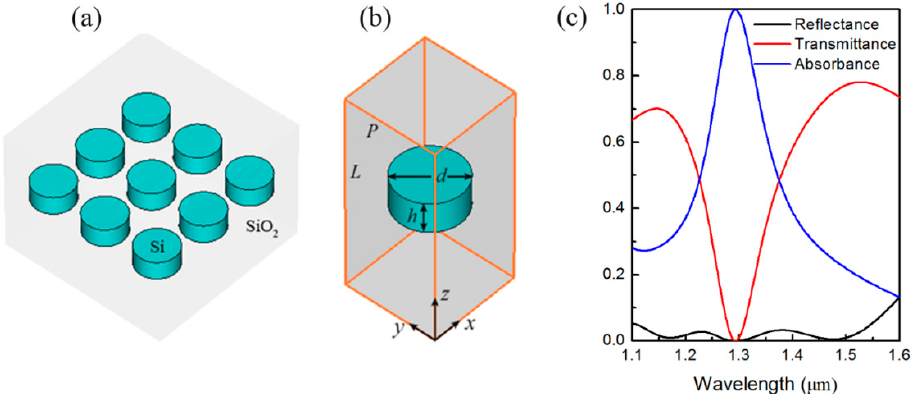
Figure 1. Schematic representation of narrowband all-dielectric metasurface composed of only a single layer of subwavelength semiconductor resonators and its spectral properties. ( a ) Periodic array structure composed of silicon nanodisks embedded into silicon dioxide. ( b ) Unit cell structure with its geometric parameters indicated, where h = 220 nm, d = 470 nm, L = 1440 nm, and P = 670 nm. ( c ) Numerically calculated reflectance (black line), transmittance (red line), and absorbance (blue line) spectra.